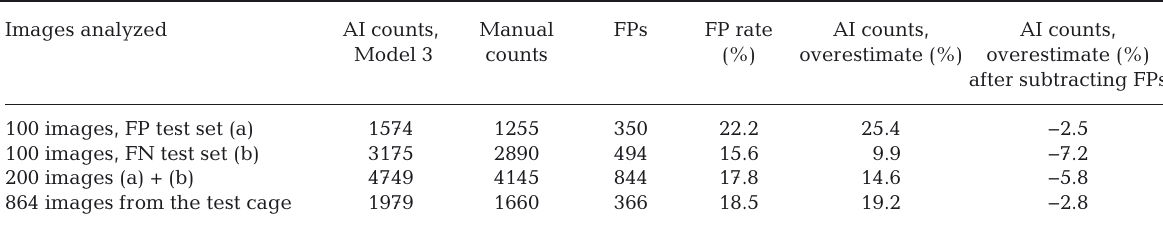
Table 5. Total fish counts by manually counting and by artificial intelligence (AI) Model 3 using a false positive (FP) test set (100 images that had the highest number of FPs when Model 1 was used), false negative (FN) test set (100 images that had highest number of FNs when Model 1 was used), the combined test set, and images from the test cage (Cage 1 on 8 July 2020). The percentage of AI overestimates were determined as: [(AI counts − manual counts) / (manual counts)] × 100. The final column shows how subtraction of FPs changed the fit of the AI counts (by Model 3) to the manual Images analyzed AI counts, Manual FPs AI counts, AI counts, Model 3 counts (%) overestimate (%) overestimate (%) after subtracting FPs 100 images, FP test set (a)